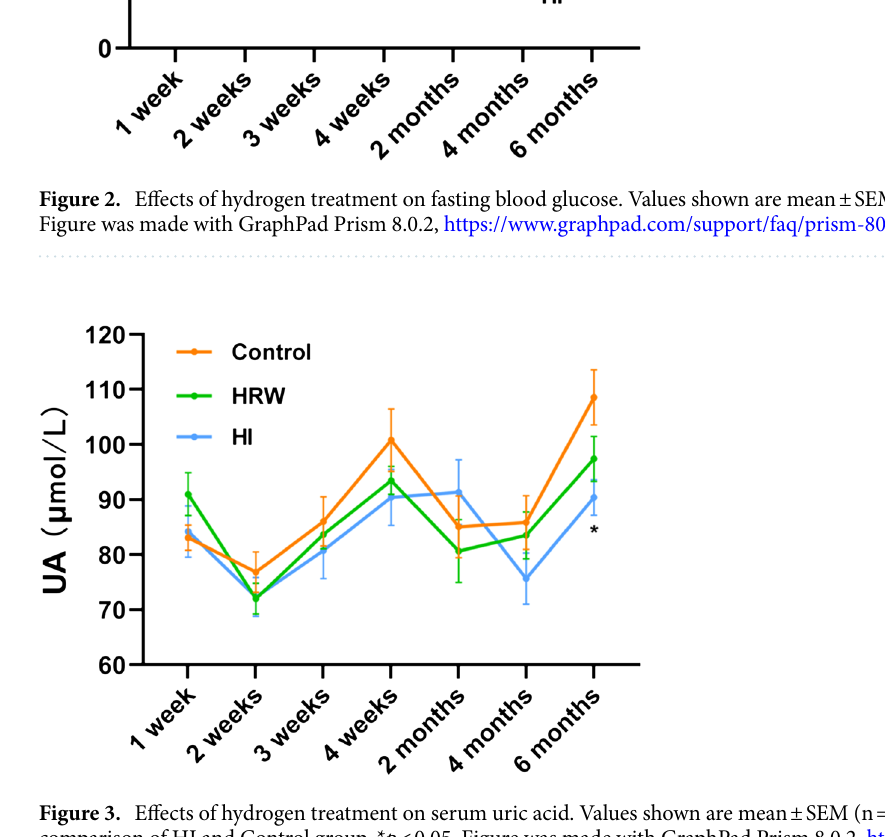
to the sixth month (the second month: 0.24 ± 0.032 mmol/L vs. 0.33 ± 0.026 mmol/L, p = 0.087; the fourth month: 0.34 ± 0.014 mmol/L vs. 0.40 ± 0.019 mmol/L, p = 0.058; the sixth month: 0.37 ± 0.013 mmol/L vs. 0.51 ± 0.024 mmol/L, p = 0.0005) (Fig. 4D).